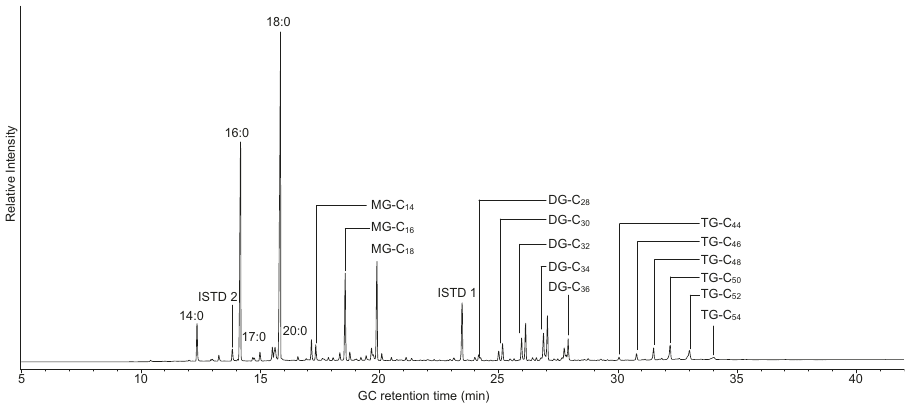
Fig. 2 | GC-FID chromatogram of the lipid extract from sample LAN16-8a after trimethylsilylation. Peaks labelled as 14:0 – 20:0 are saturated fatty acids with 14 – 20 carbon atoms, while MG, DG and TG denote mono-, di- and triacylglycerols